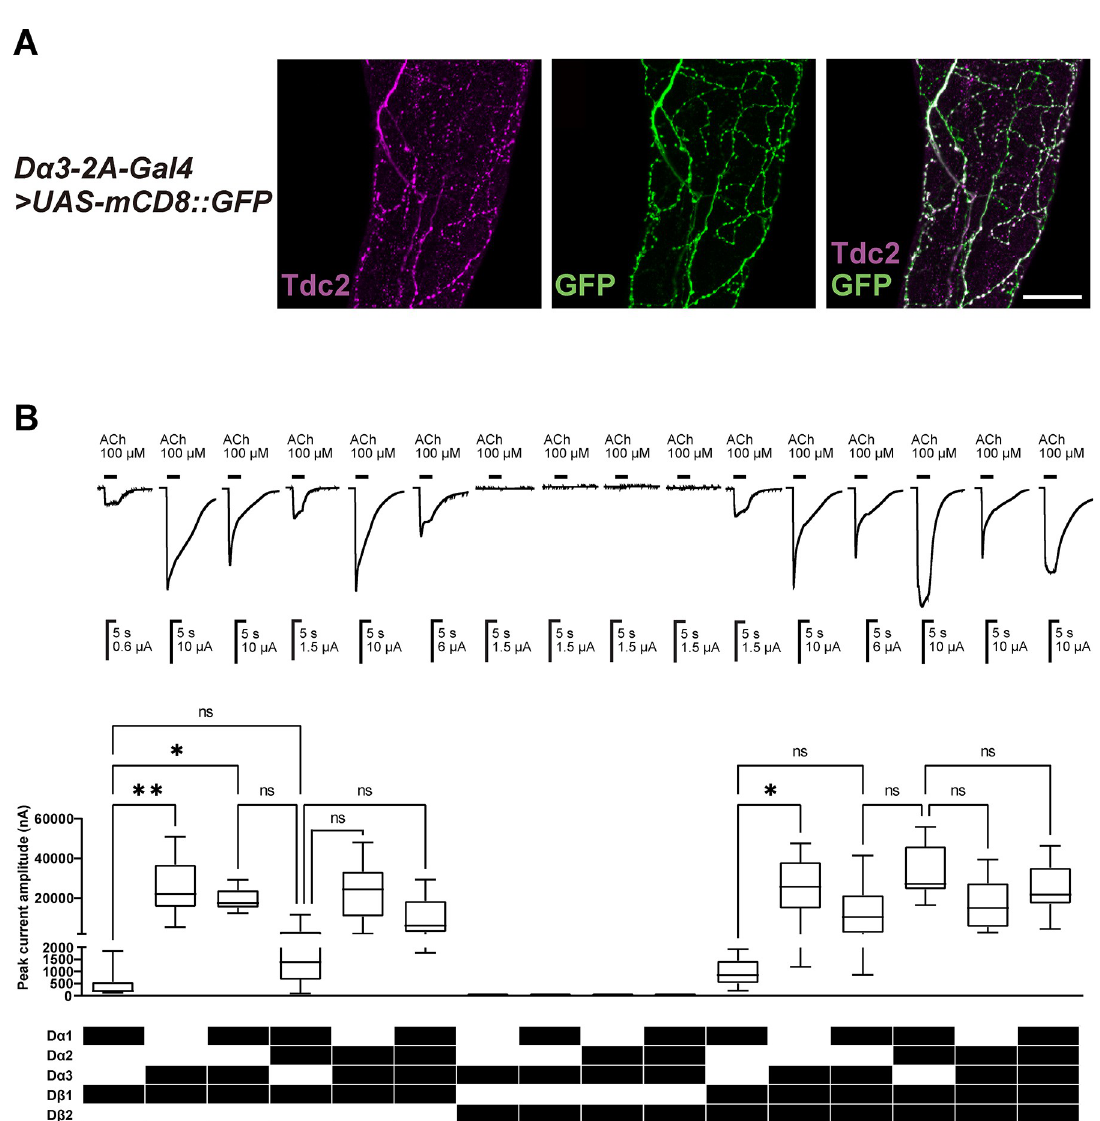
Fig 1. Expression of D α 3 in male ejaculatory duct neurons of D . melanogaster and characteristics of nAChRs expressed in X . laevis oocytes. ( A ) D α 3 is expressed in the ejaculatory ducts of male flies. Male ejaculatory ducts from D α 3-2A-Gal4 > UAS-mCD8 :: GFP were immunostained for Tdc2 (magenta) and GFP (green). If both signals are overlapped, merged signals are shown in white. Scale bar: 25 μ m. The D α 3 subunit is expressed in the neurons where D α 1, D α 2, D β 1, and D β 2 subunits are also expressed [30]. ( B ) Current responses to 100 μ M ACh of nAChRs reconstructed with D α 1, D α 2, D α 3, D β 1, and D β 2 subunits in X . laevis oocytes. Each box plots represents 75 and 25% percentiles of data and horizonal line in each box indicates the median of data (n = 10). Whiskers indicate the range of data. The current amplitude of the ACh-induced response was compared by Kruskal-Wallis tests ( � , P < 0.05; �� , P < 0.01). ns: not significant. α -Bungarotoxin ( α -BTX), a peptide toxin known to block certain insect nAChRs [32], was tested on D . melanogaster nAChRs expressed in X . laevis oocytes. We found that 100 nM α - BTX effectively blocked the ACh-induced responses of nAChRs containing the D α 1 subunit ( Fig 2B, and Fig B in S1 Text ). In contrast, α -BTX was ineffective on nAChRs lacking the D α 1 subunit. Notably, α -BTX showed a minimal blocking effect on the D α 3/D β 1, D α 2/D α 3/ D β 1, and D α 3/D β 1/D β 2 nAChRs ( Fig 2B and Fig B in S1 Text ). These findings accord with an earlier observation that D α 1/chicken β 2 nAChR was sensitive whereas D α 2/chicken β 2